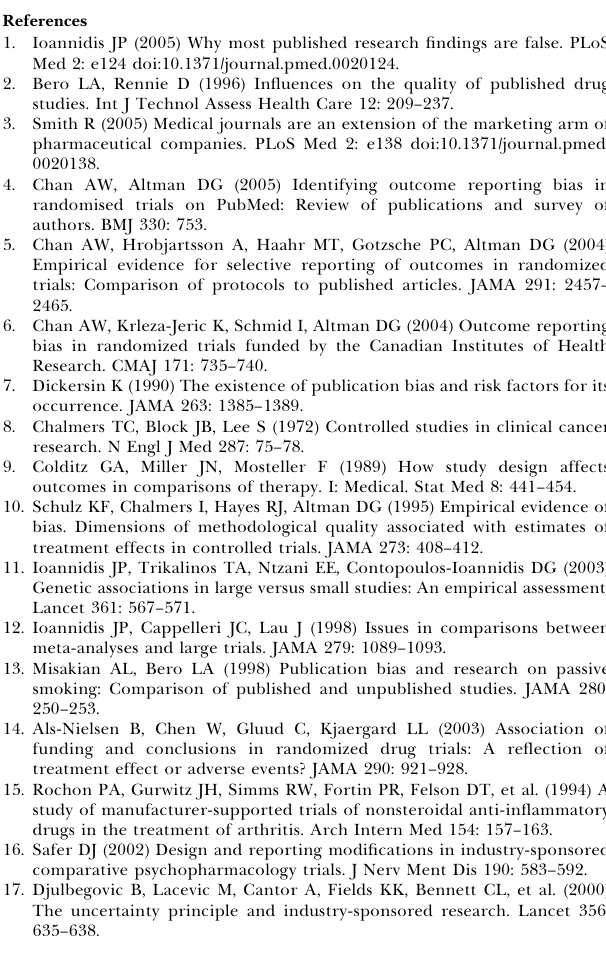
Table S1. Included Studies Table Table S2. Statin Data: Adjudicated Full and Subsample Table S3. Statin-Only Comparison